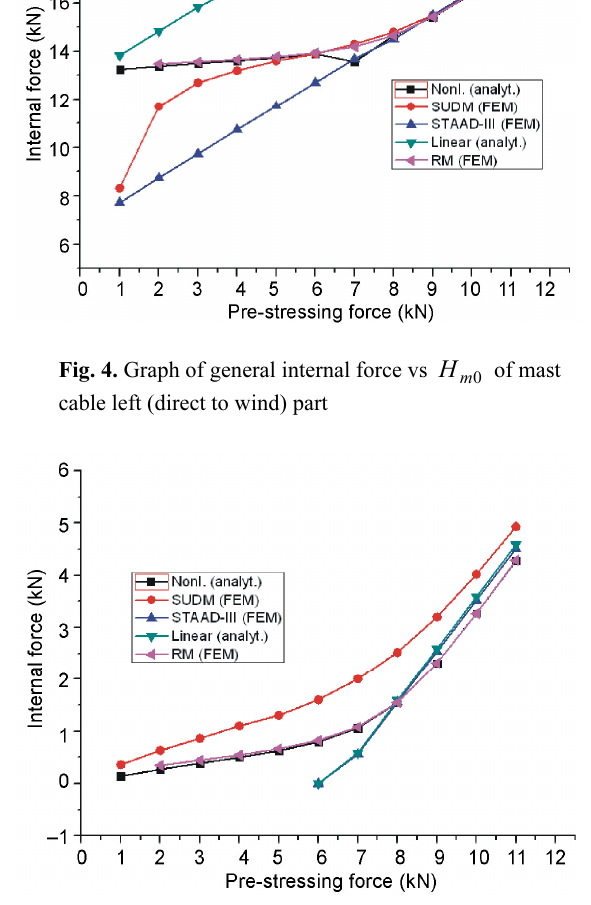
Fig. 2. Graph of mast stem (pole) upper displacement vs pre-stressing force in case of